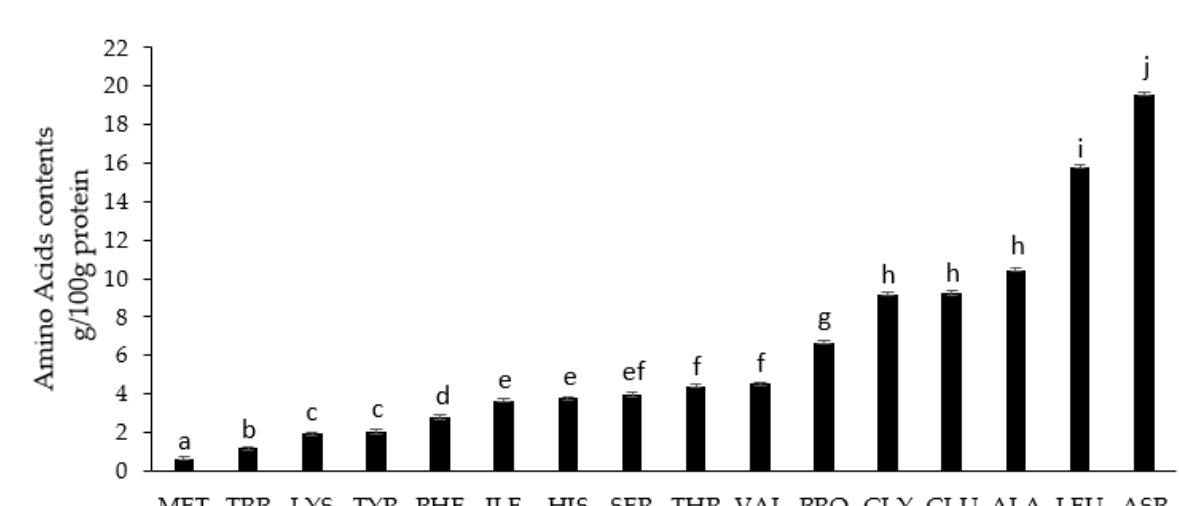
Figure 1. Amino acids contents of Ulva rigida from Akhfenir coastal. Results are means ± S.D. Different letters in a single line show statistically significant differences for p < 0.05 level. Abbreviations are as follows: Met: Methionine, Trp: Tryptophan, Lys: Lysine, Tyr: Tyrosine, Phe: phenylalanine, Ile: Isoleucine, His: Histidine, Ser: Serine, Thr: Threonine, Val: Valine, Pro: proline, Gly: Glycine, Ala: Alanine, Leu: Leucine, Asp: Aspartic Acid.